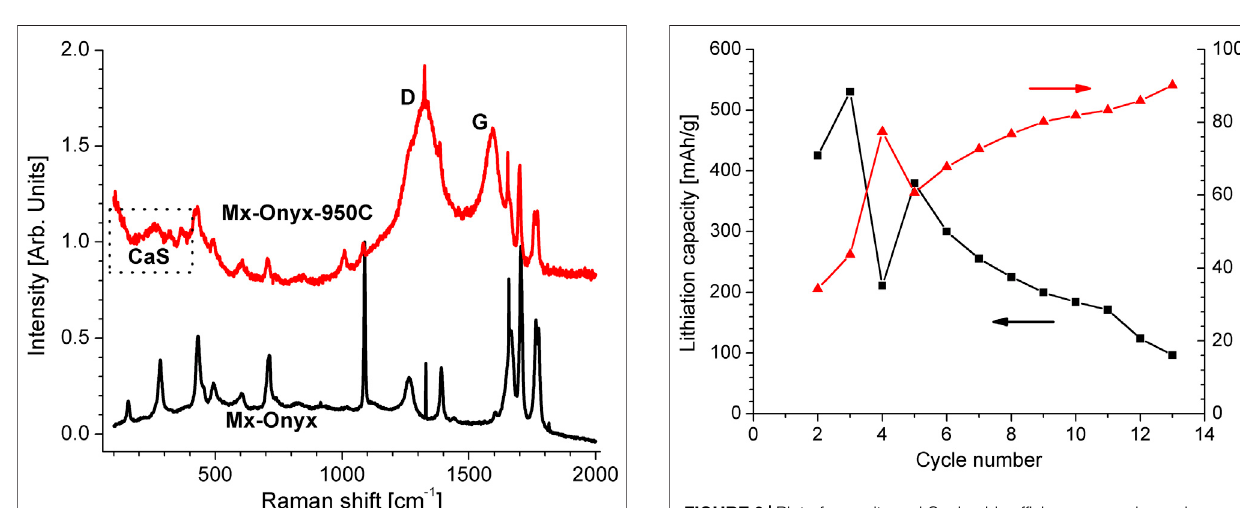
FIGURE 6 | Plot of capacity and Coulombic ef fi ciency vs. cycle number of a half battery cell with Mx-Onyx as working